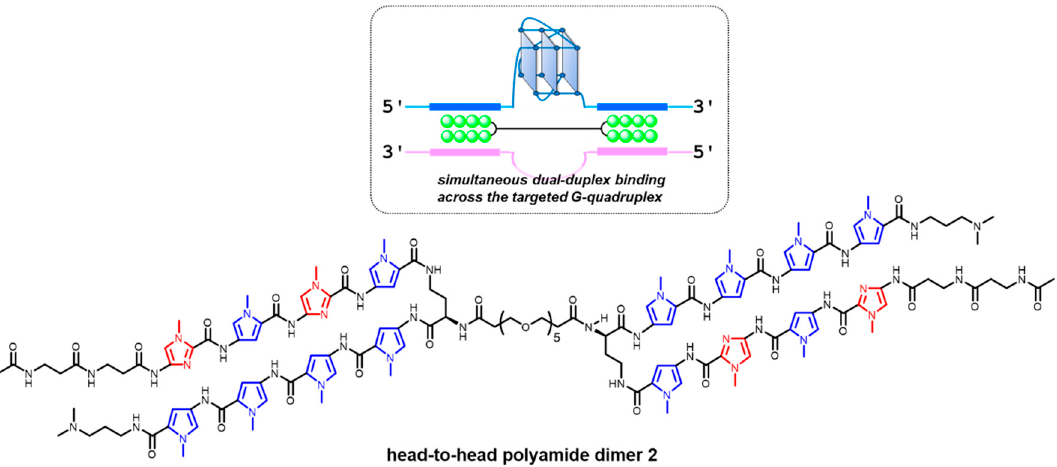
Figure 11. Head-to-head polyamide dimer that can target a certain G4 by simultaneously binding to dual-duplex sites across the G4. N -Methylpyrrole is highlighted in blue, and N -methylimidazole is highlighted in red.